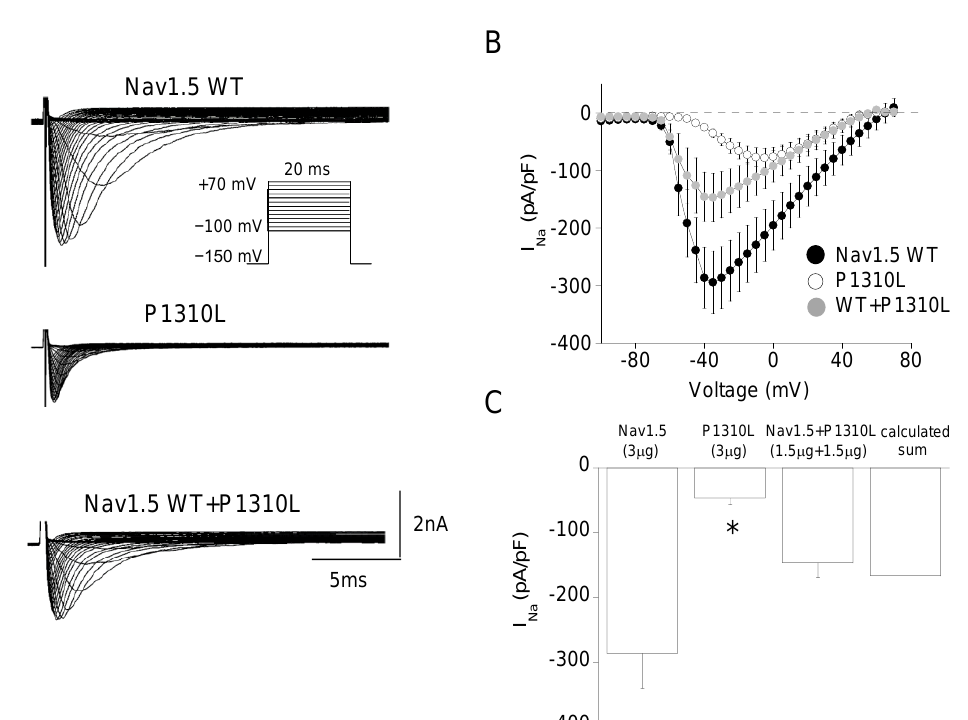
Figure 3. Current density of Nav1.5 WT, P1310L and WT+P1310L channels expressed in HEK 293 cells. ( A ) Representative sodium current traces from cells transfected with Nav1.5 WT (3 µg), P1310L (3 µg), and Nav1.5+P1310L (1.5 µg +1.5 µg) cDNAs. The voltage protocol is shown in the inset. ( B ) IV plot showing the mean current density of Nav1.5 WT, P1310L and Nav1.5+P1310L channels as a function of membrane potential. ( C ) Bar graph showing the mean current density measured at − 30mV for the indicated channels. Data are mean ± SE; n = 11–20 cells. * p < 0.05 for P1310L channels compared with Nav1.5 WT.